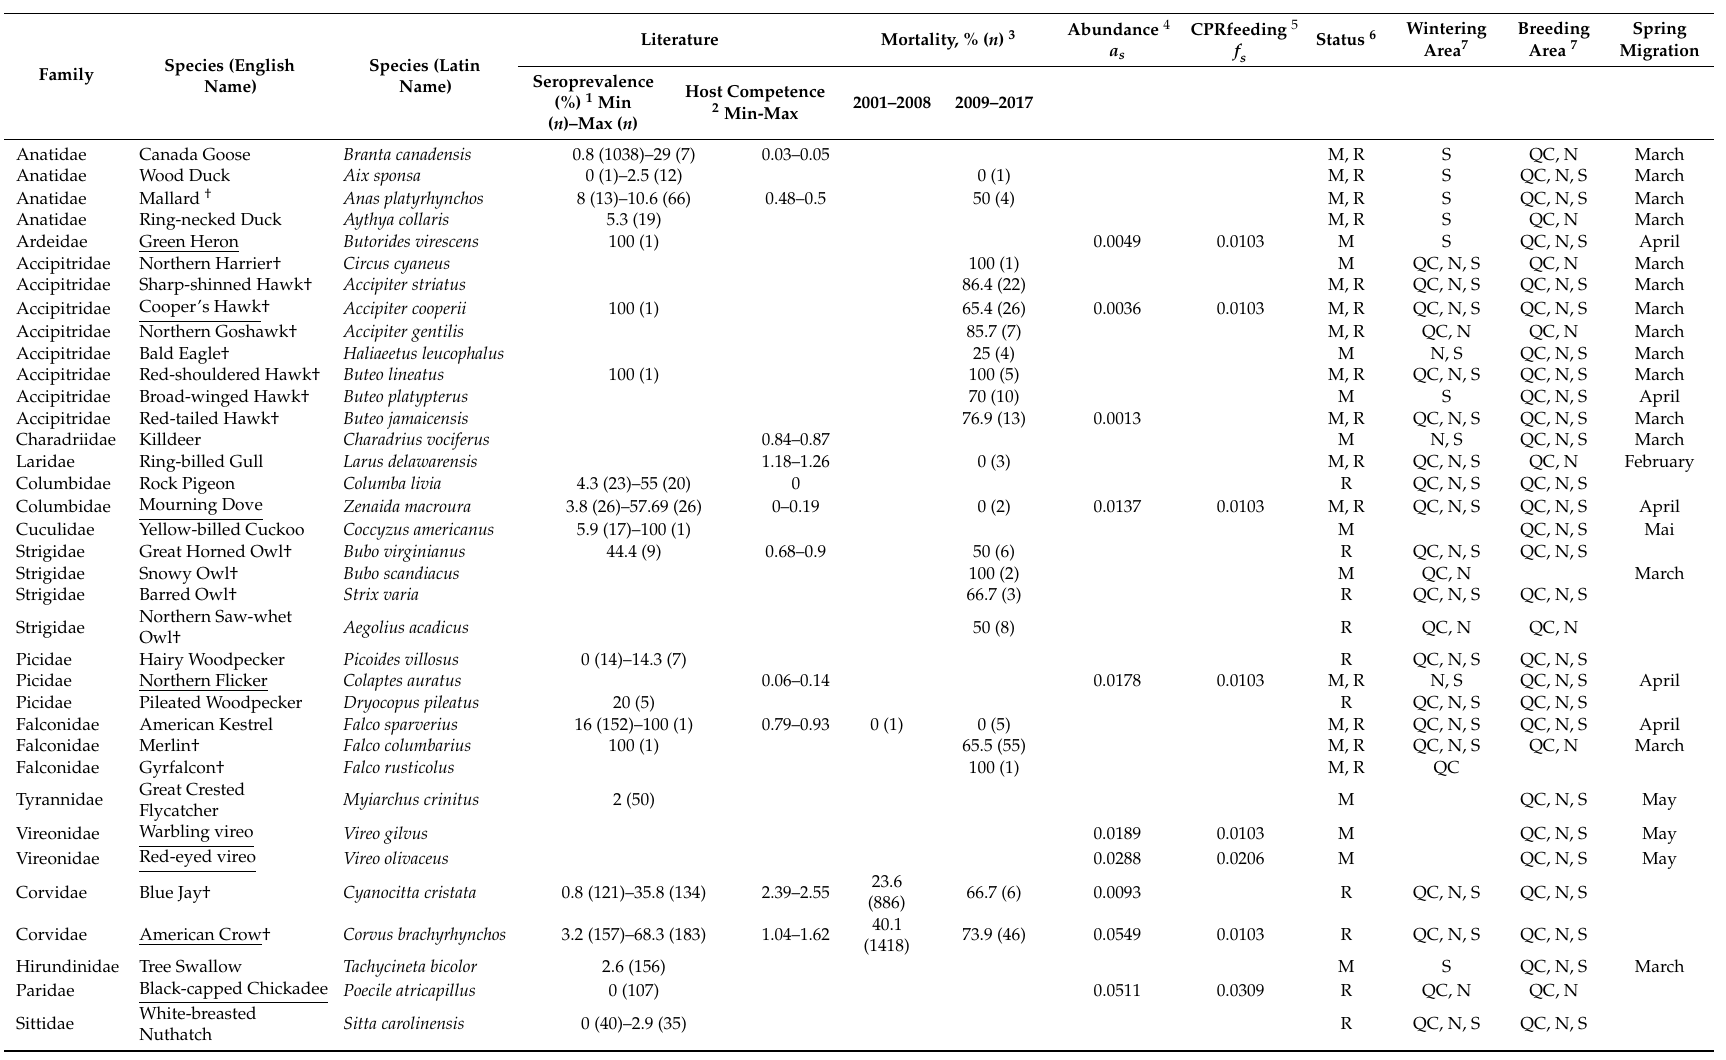
Table 3. Characteristics of bird species a ff ected by WNV in the Montr é al